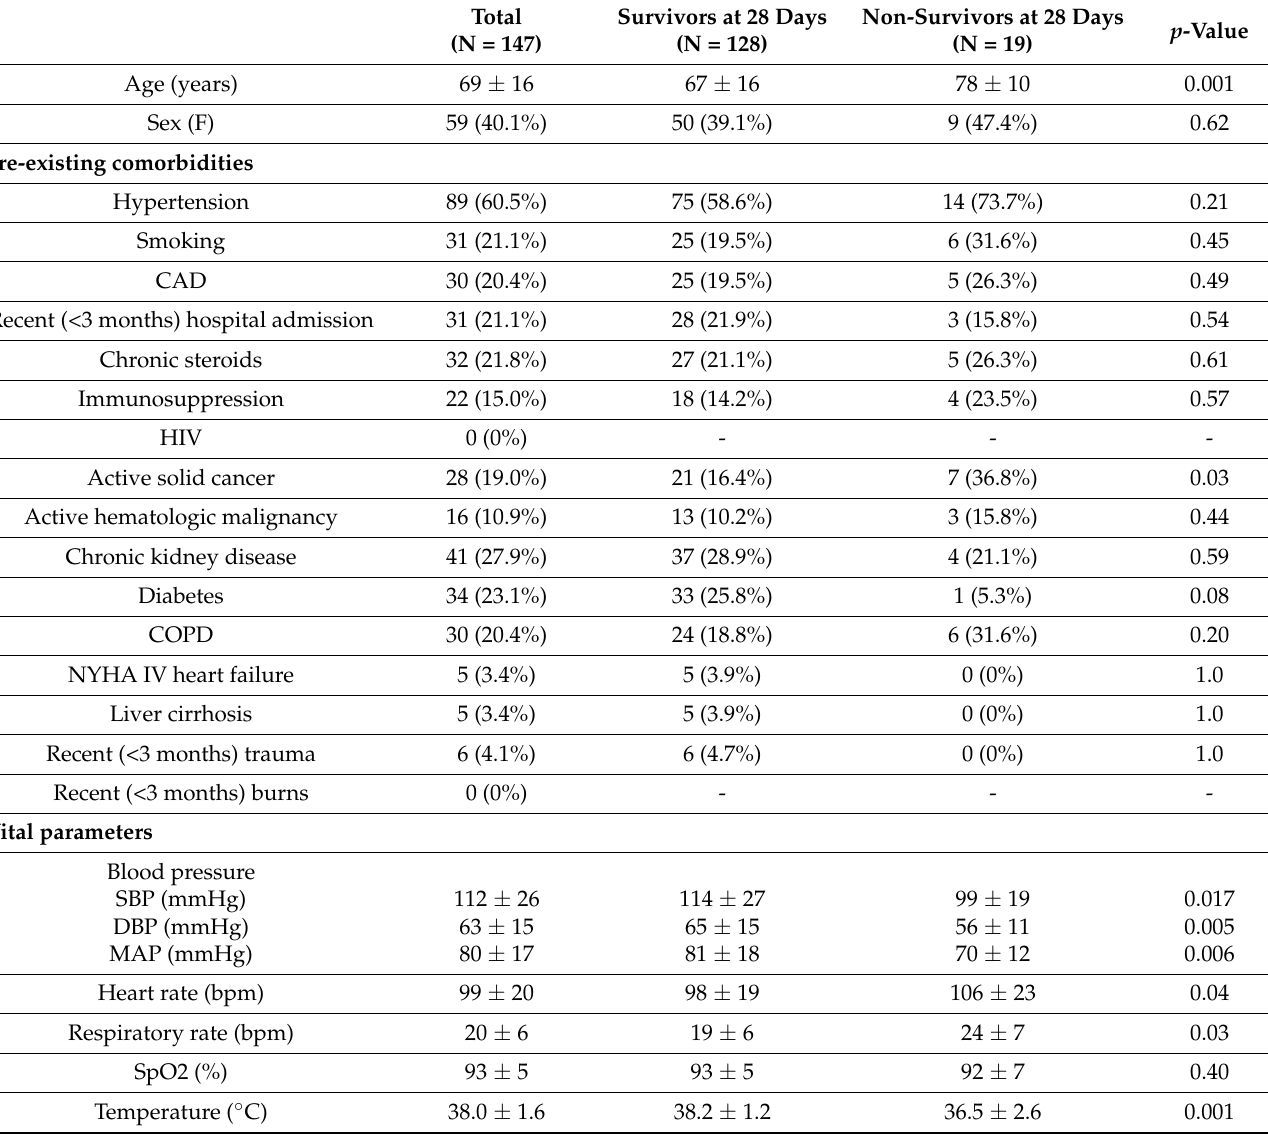
Table 1. Clinical characteristics of the